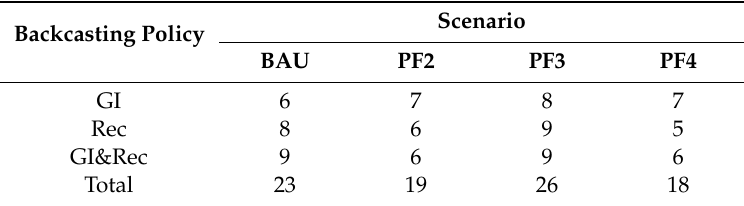
Table 14. The number of average ES levels (out of 10, all 10 average ES levels are presented in Table 12) that stay the same or move towards the desired end point, by potential future (PF) and backcasting policy in the NM